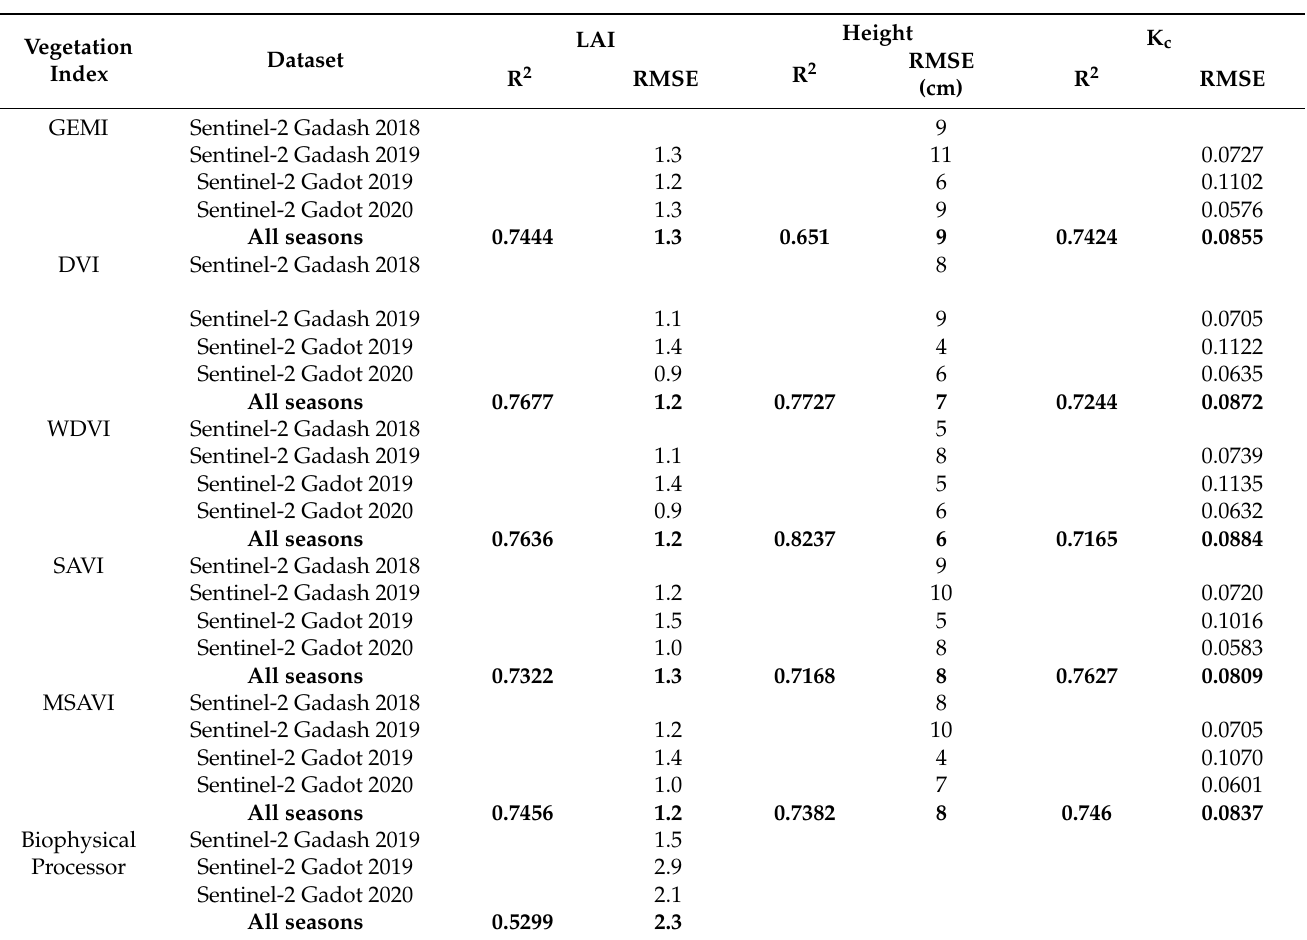
Table 5. Performance statistics of newly developed Sentinel-2-based LAI, Height, K c models for the best performing VIs, and the SNAP biophysical processor LAI estimation algorithm’s performance. Performance statistics of additional VIs can be found in Appendix